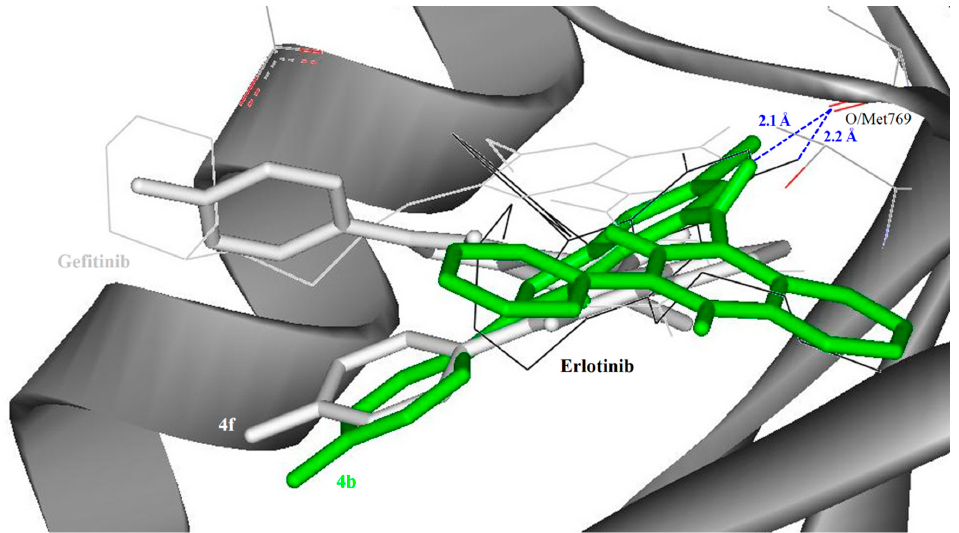
Figure 5. Docked conformation of erlotinib (as control), gefitinib, indole-aminoquinazolines 4b and 4f (stick representation) in the binding pocket of the EGFR kinase domain (surface and ribbon representation). Blue dotted lines indicate the direct hydrogen bonding formed between the docked ligand and EGFR. The docked conformation of other indole-aminoquinazolines can be found in Supplementary data Figure S2.